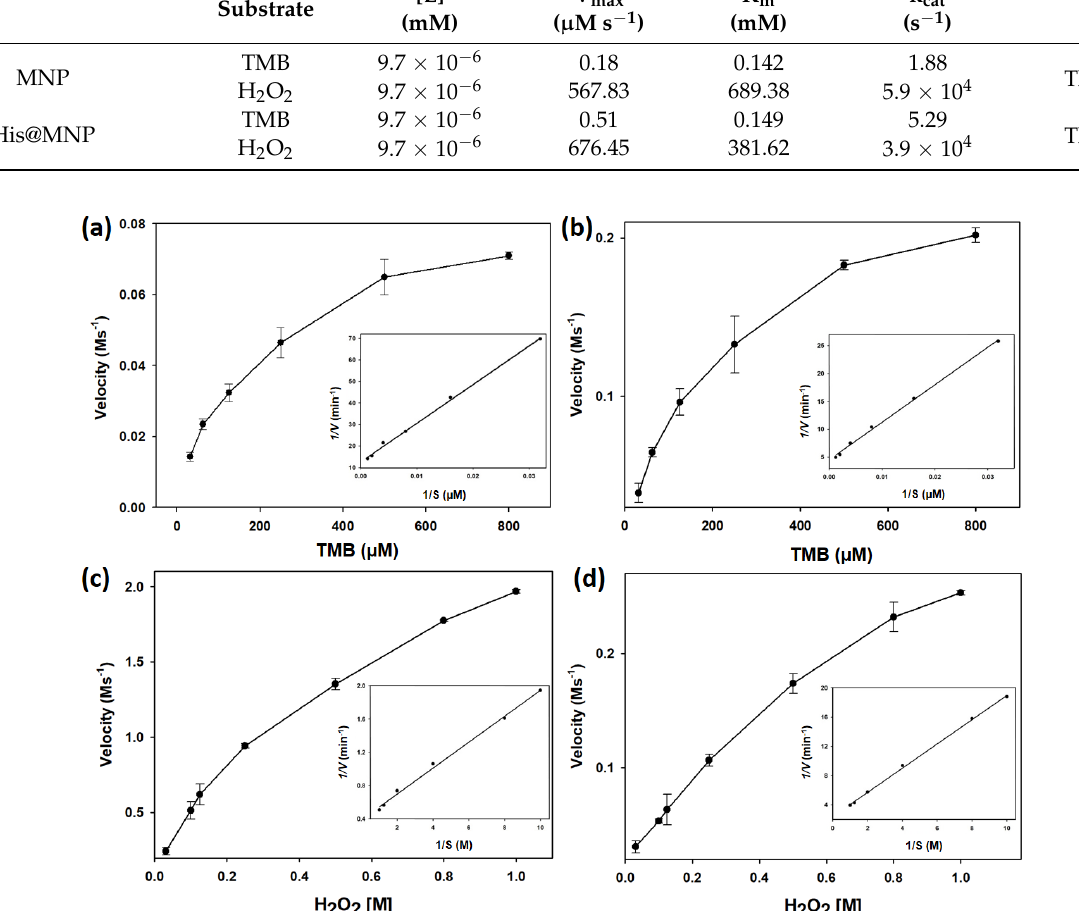
Figure 3. Steady-state kinetic assays of ( a ) His@MNPs and ( b ) pristine MNPs with TMB as substrate and their corresponding double reciprocal (Lineweaver-Burk) plots of activity. H 2 O 2 substrate was used in the steady-state kinetic assays performed by ( c ) His@MNPs and ( d ) pristine MNPs.